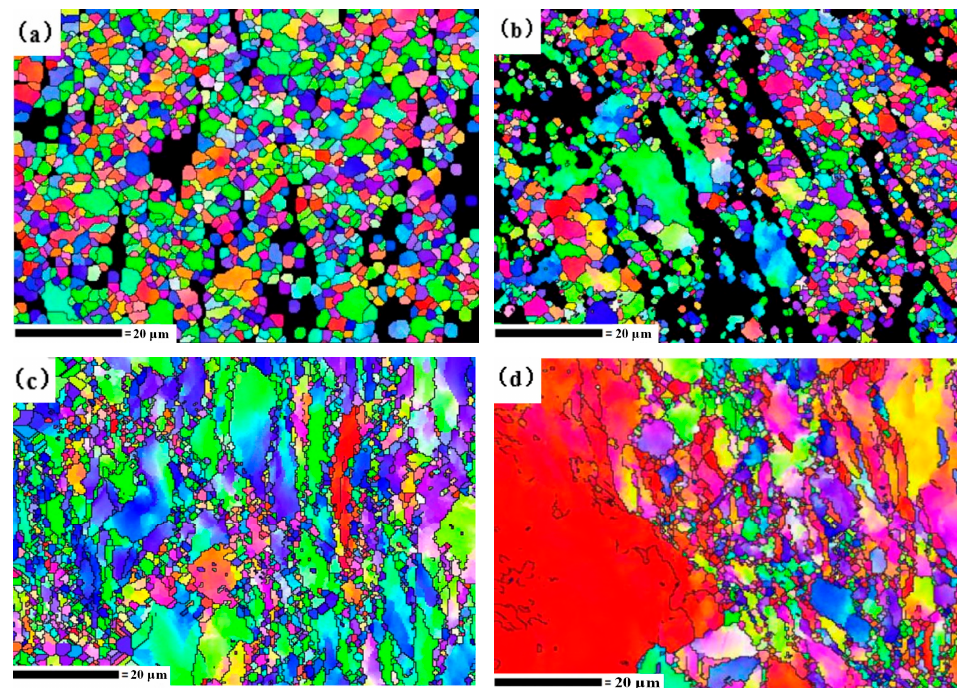
Figure 5. The IPF maps ( a – d ) of compressed samples under different conditions: ( a ) 400 °C/0.001 s − 1 ; ( b ) 350 °C/0.001 s − 1 ; ( c ) 300°C/0.001 s − 1 ; and ( d ) 300 °C/0.01 s − 1 .